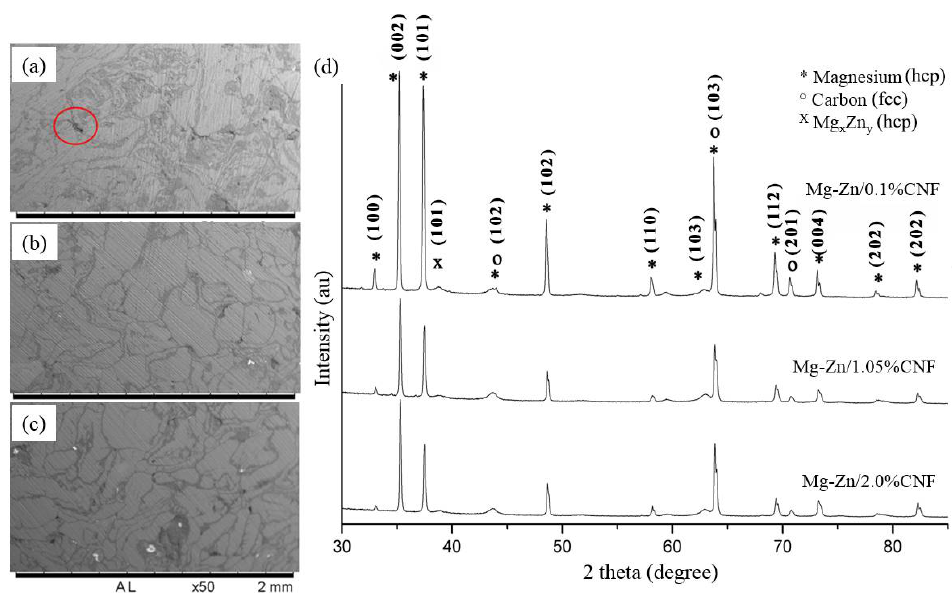
Figure 2. SEM micrographs of: ( a ) Mg–Zn/0.1% carbon nanofiber (CNF), ( b ) Mg–Zn/1.05% CNF and ( c ) Mg–Zn/2.0% CNF, and ( d ) XRD pattern of the three main phases found in all sintered spec- imens.